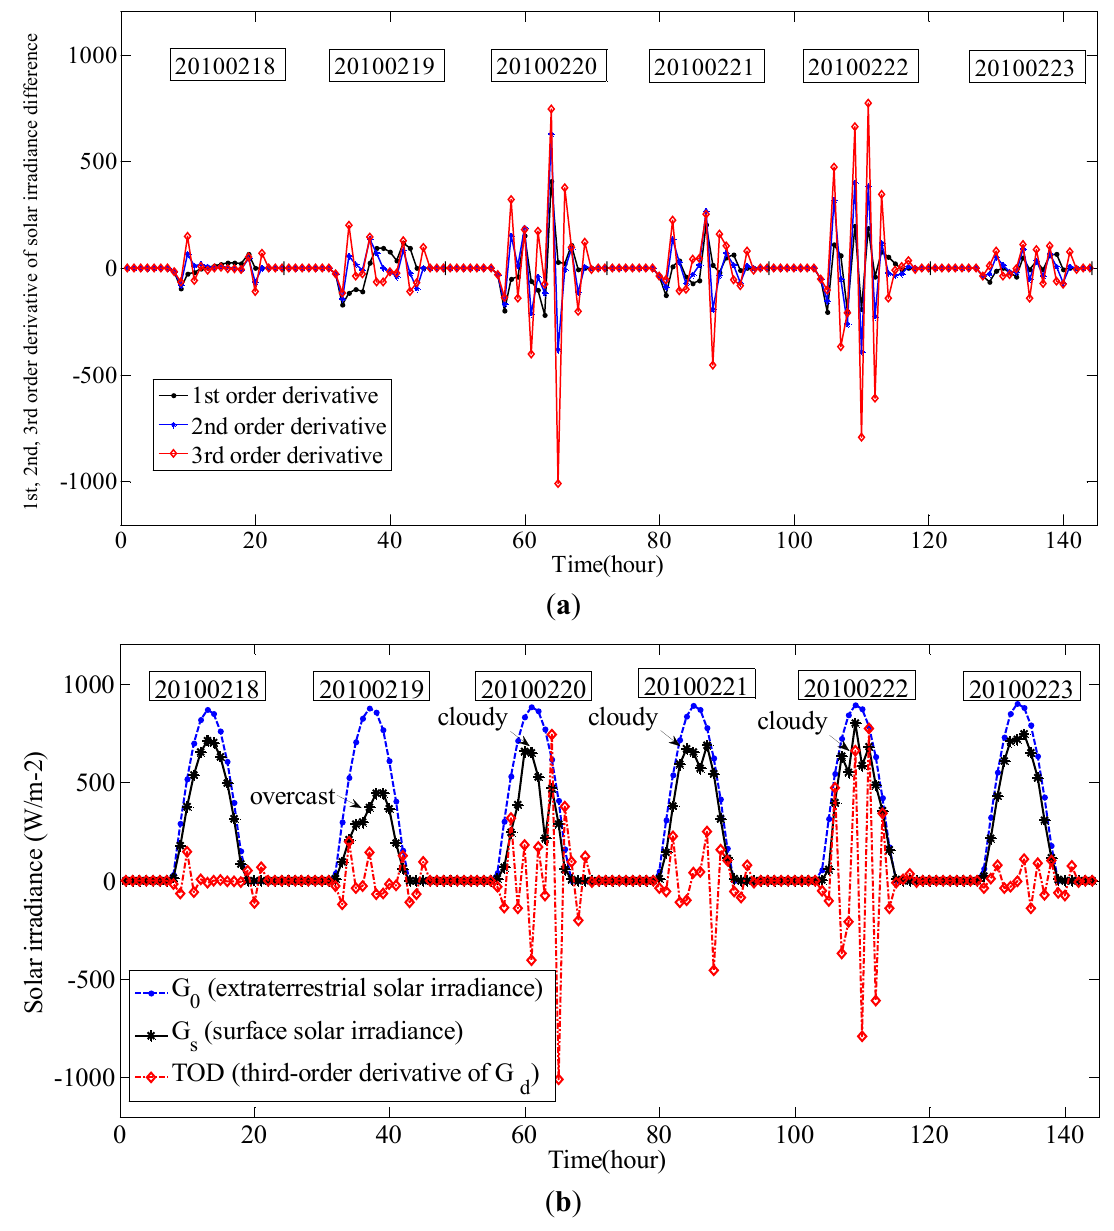
Figure 2. Solar irradiance and the derivatives of solar irradiance difference; ( a ) First-order, second-order and third-order derivative of solar irradiance difference; ( b ) Extraterrestrial solar irradiance, surface solar irradiance and TOD